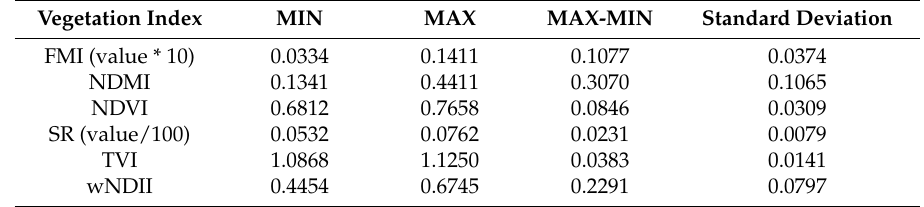
Figure 18. Time series of the vegetation indices of the areas with minimal disturbance ( a ); and the statistical information ( b ) (the average from the Sumava National Park) (Source: Own work). Table 8. Statistical information about the average values in the disturbed areas in the Sumava